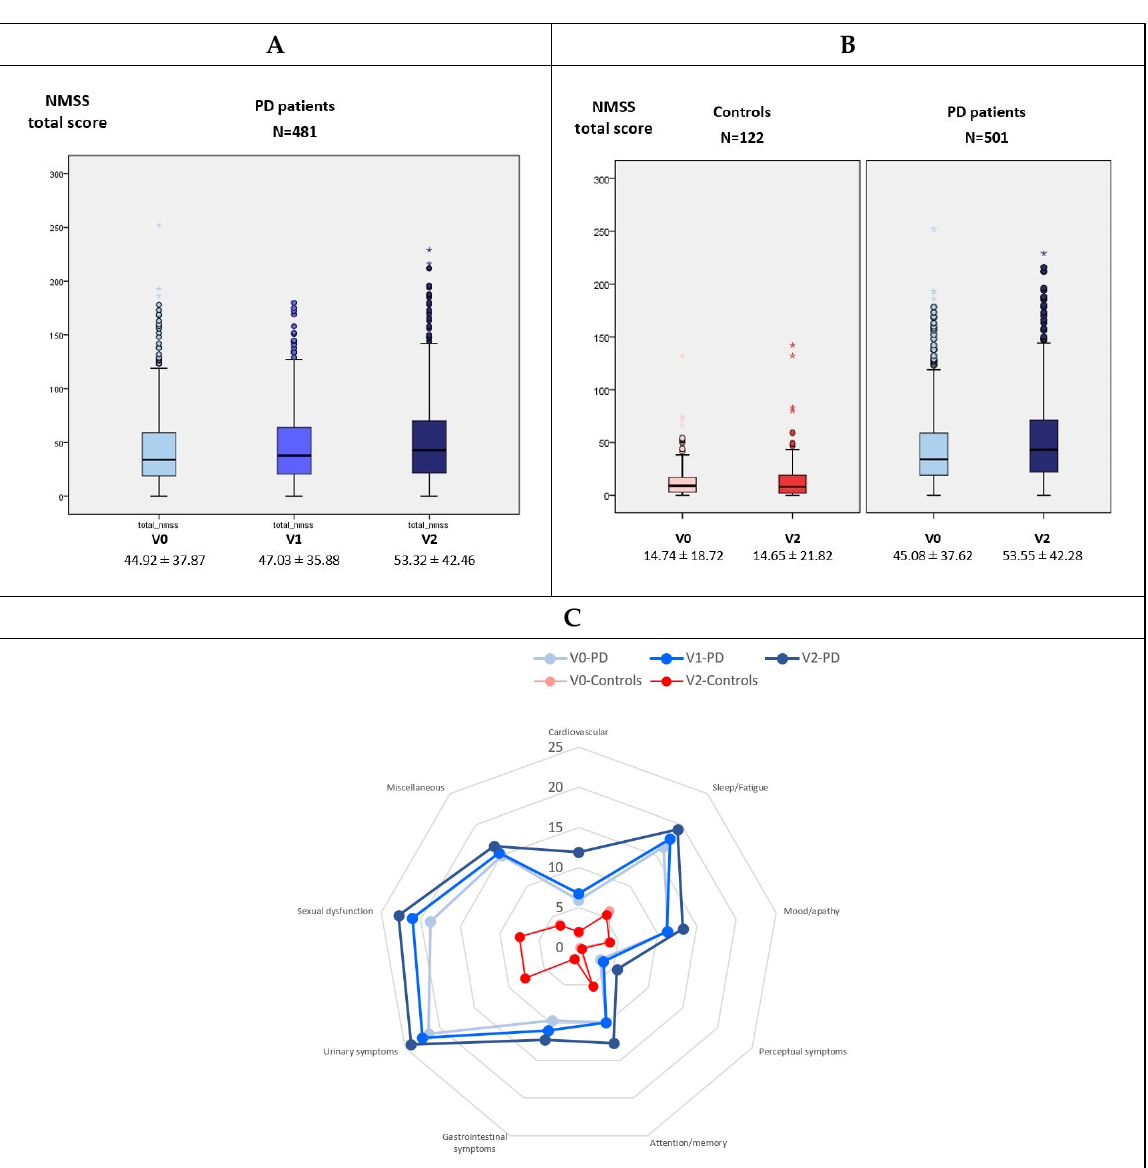
Figure 1. ( A ) Mean NMSS total score at V0 (baseline), V1 (1 year follow-up ± 1 month), and V2 (2-year follow-up ± 1 month) in PD patients (N = 481). V1 vs. V0, p < 0.0001; V2 vs. V1, p < 0.0001; V2 vs. V0, p < 0.0001; All groups; p < 0.0001. ( B ) Change from V0 to V2 in the mean NMSS total score in PD patients (N = 501) and controls (N = 122). V2 vs. V0 in controls, p = 0.944; V2 vs. V0 in PD patients, p < 0.0001; difference in the change from V0 to V2 between PD patients and controls, p = 0.002. ( C ) Mean score on each domain of the NMSS scale at V0, V1, and V2 in PD patients (blue) and controls (red). Data (A and B) are presented as box plots, with the box representing the median and the two middle quartiles (25–75%). P values were computed using general linear models (GLM) repeated measures. Mild outliers (O) are data points that are more extreme than Q1 − 1.5 × IQR or Q3 + 1.5 × IQR. NMSS, Non-Motor Symptoms Scale.